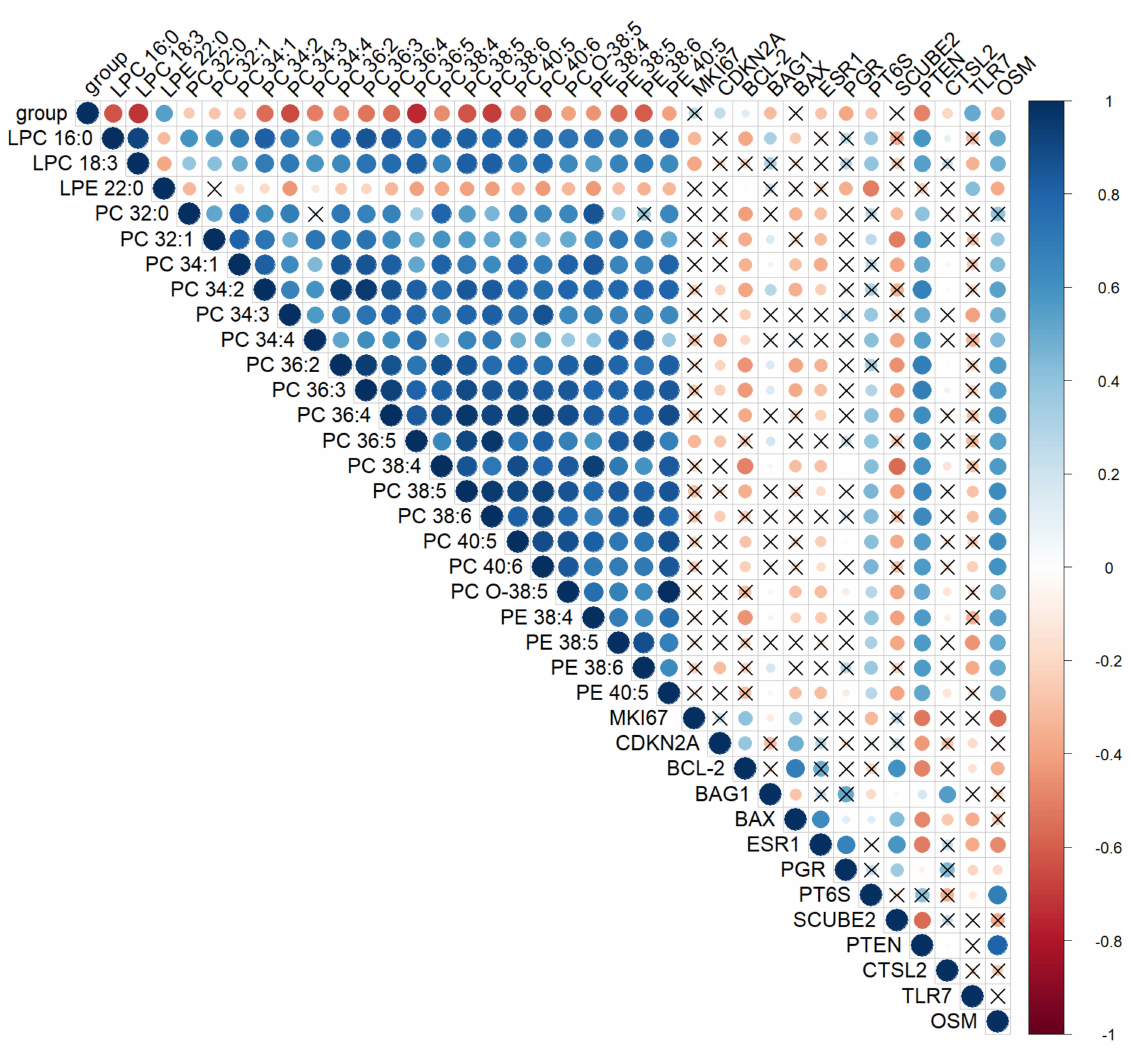
Figure 4. Spearman’s correlation analysis of the cervical tissues’ lipid profile in CINs and SCC, histological diagnosis, and gene mRNA expression levels at a confidence level of 0.05. Positive correlation is highlighted in blue and negative correlation in red. The degree of correlation is highlighted in color—the stronger the correlation, the darker the color. “X”—correlations with p -value > 0.05. Parameter group shows the degree of cervical epithelium transformation: 0-ChC, 1-LSIL, 2-HSIL, and